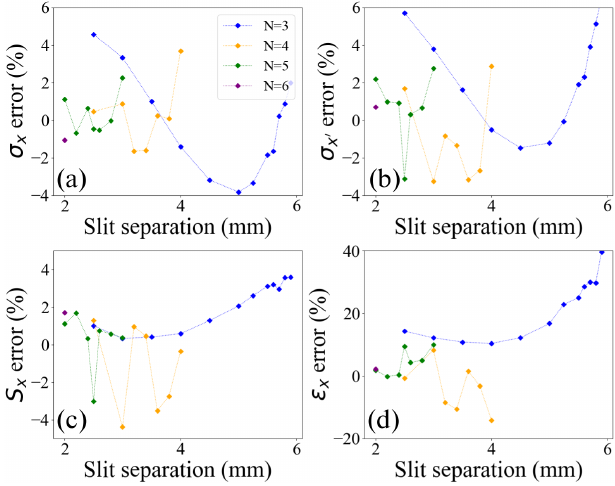
FIG. 8. Simulated measurement errors for each second moment as a function of the number of slit openings and the separation. Each panel corresponds to each second moment. Errors in figures are estimated values from the start-to-end